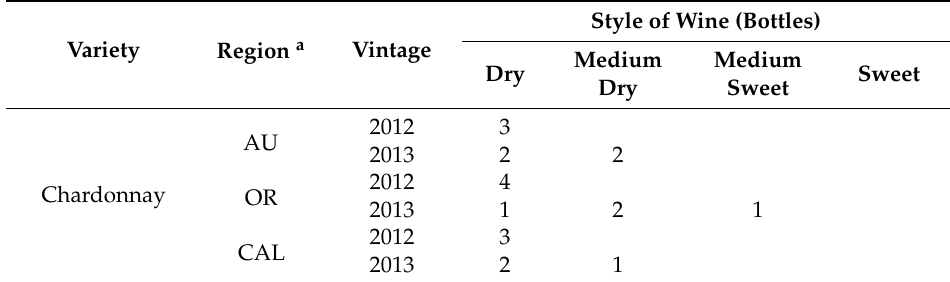
Table 1. Distribution of varietal wines across, region of origin, vintage and wine